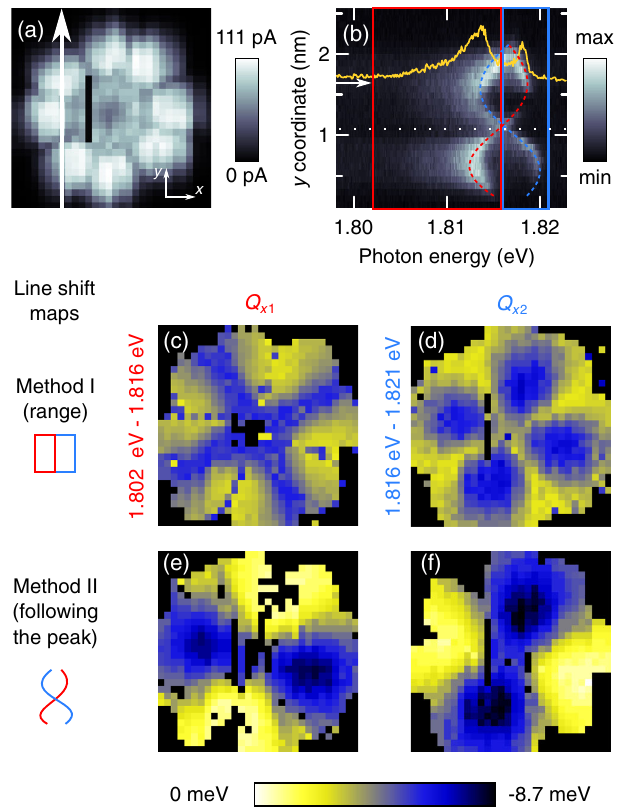
FIG. 5. HRFM mapping of a type-2 H 2 Pc molecule. (a) Con- stant-height STM current image ( V ¼ − 2 . 5 V, 2 . 6 × 2 . 6 nm 2 , 111 pA) of a type-2 H I 2 Pc molecule acquired with an open max ¼ feedback loop. (b) Two-dimensional representation of successive STML spectra acquired for STM tip positions along the white arrow in panel (a). A spectrum corresponding to the STM tip position marked by a short white arrow is plotted in yellow. (c) – (f) HRFM line-shift maps of Q (c,e) and Q (d,f) acquired for x 1 x 2 each pixel of the map in panel (a). The maps in panels (c,d) are obtained by selecting a range defined by the colored boxes in panel (b). The maps in panels (e,f) are obtained by following the given Q exciton (dashed colored lines). Note the common color x scale for all line-shift